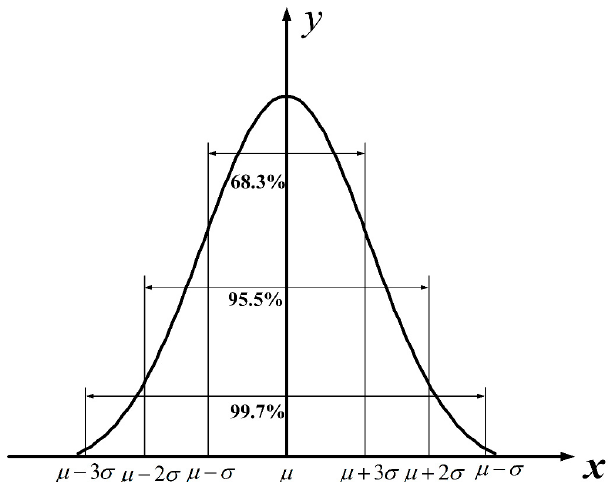
Figure 2. The normal distribution of random interference numbers.